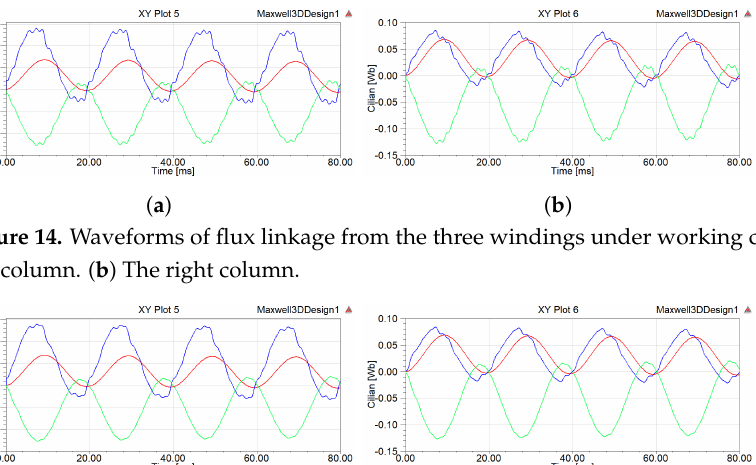
Figure 13. Waveforms of flux linkage from grid-side and valve-side windings under working condition 1. ( a ) The left column. ( b ) The right column.